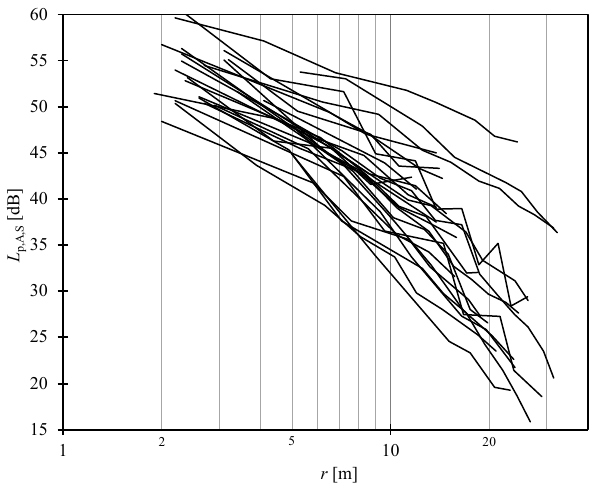
Figure 2. Measured A-weighted SPL of speech, L p,A,S , as a function of distance, r , from the omnidi- rectional loudspeaker, for the 26 open-plan offices of Table 1. The number of measurement positions per office ranged from 4 to 13. The required minimum number of positions is four.